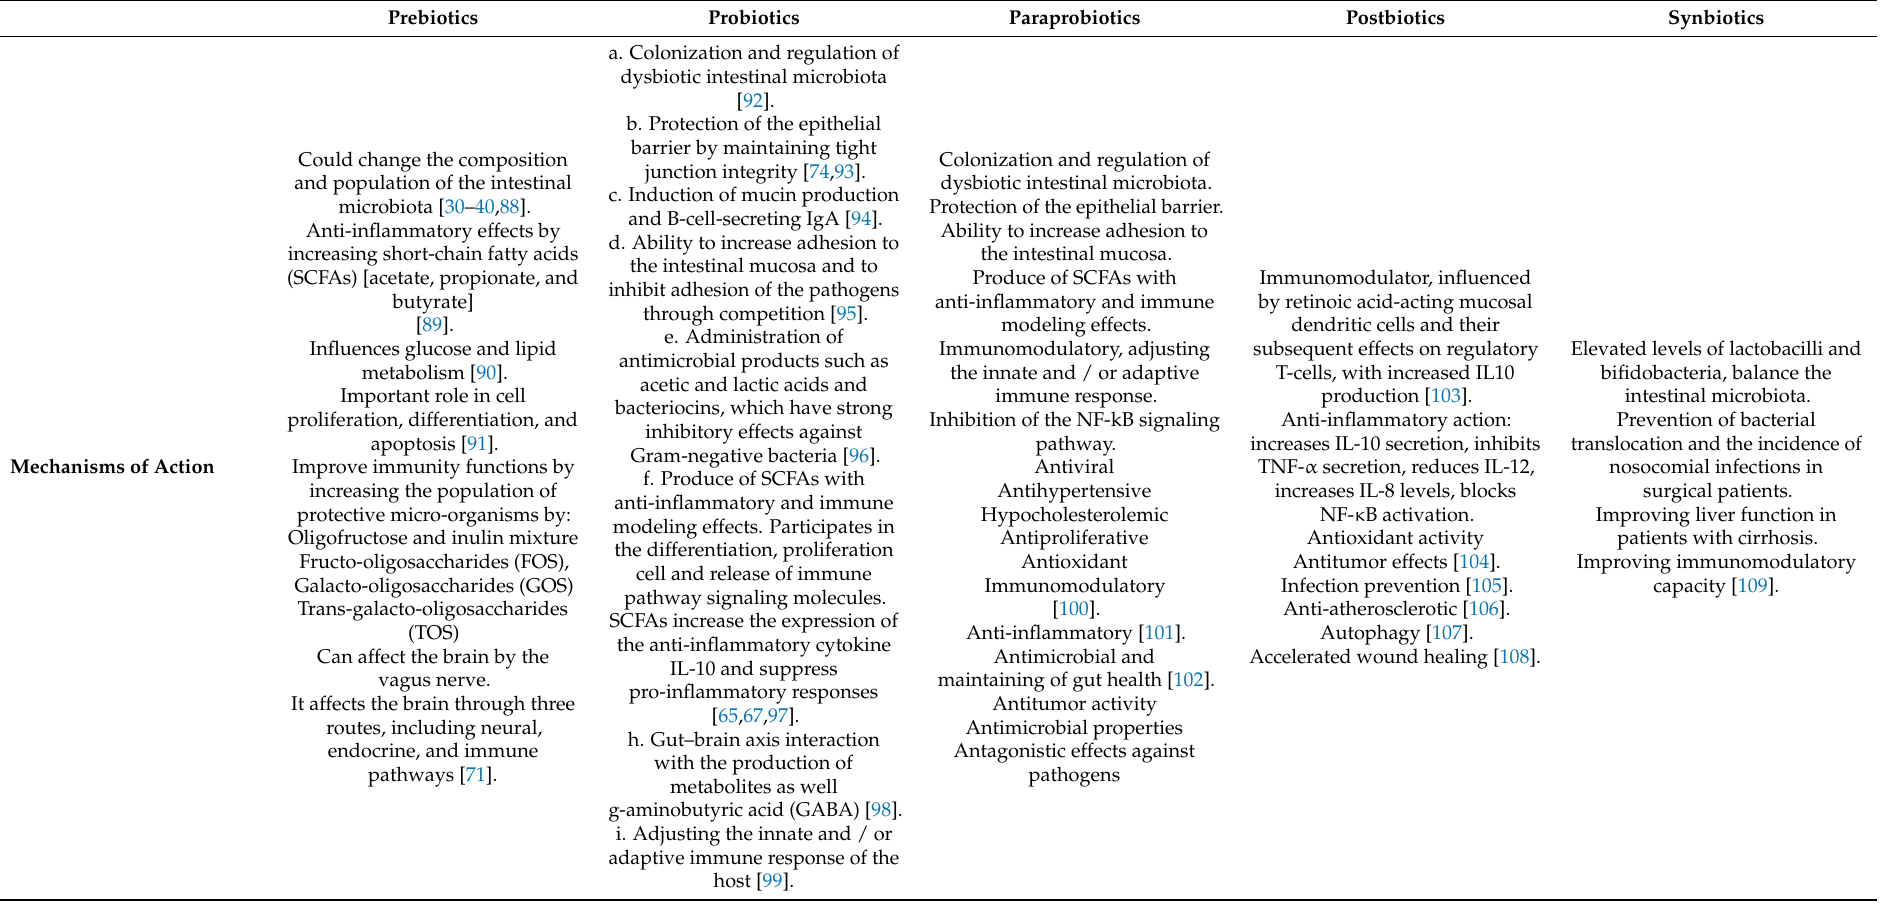
Table 2. Mechanisms of action, clinical applications and side effects of pre-, pro-, para-, post-, and synbiotics